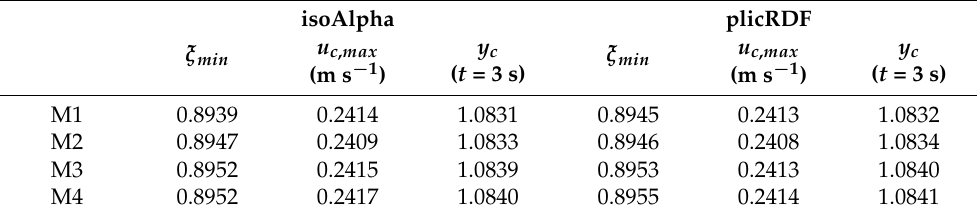
Table 4. Mesh sensitivity study results for 2D rising bubble for both isoAlpha and plicRDF methods.